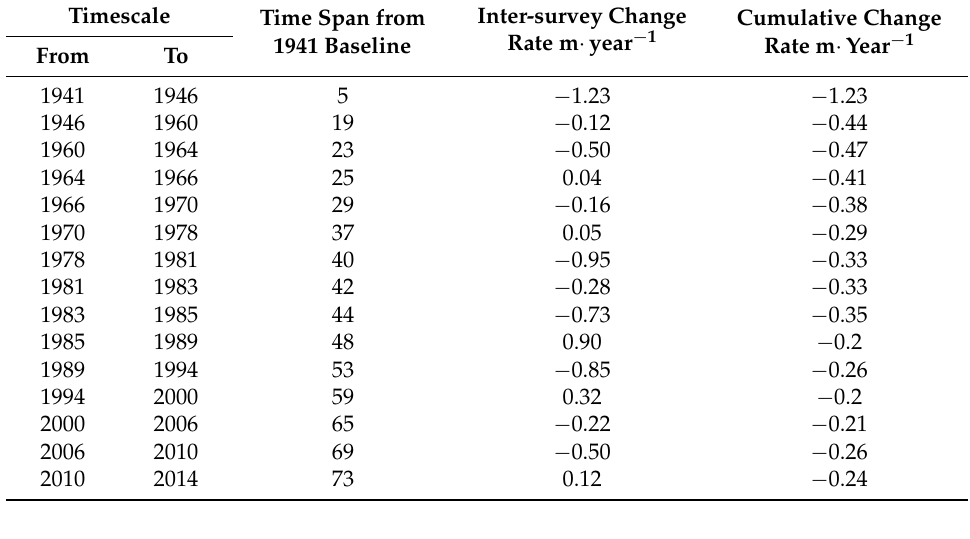
Table 3. The shoreline change rate record. (Note: negative values depict shoreline retreat, positive values depict shoreline advance and all values are in meters).